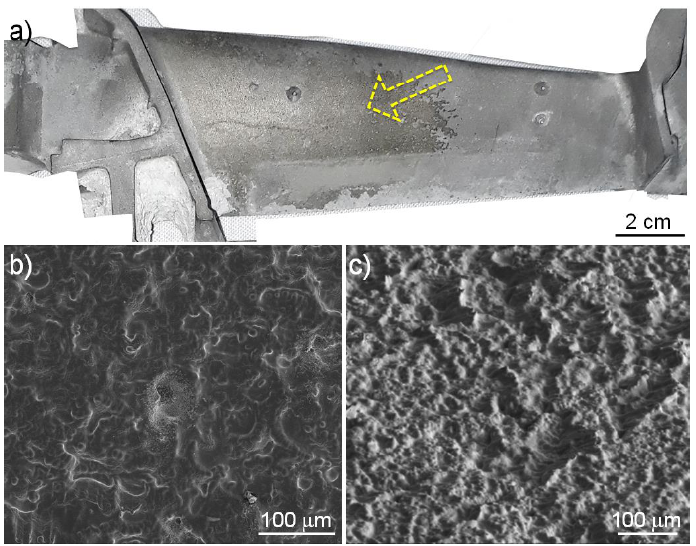
Figure 1. General images of surface scale: ( a ) silver-coloured surface scale in an as-cast turbine blade, and ( b , c ) low magnification SEM images acquired in the scaled region from a plain view ( b ) and a tilting view ( c ).